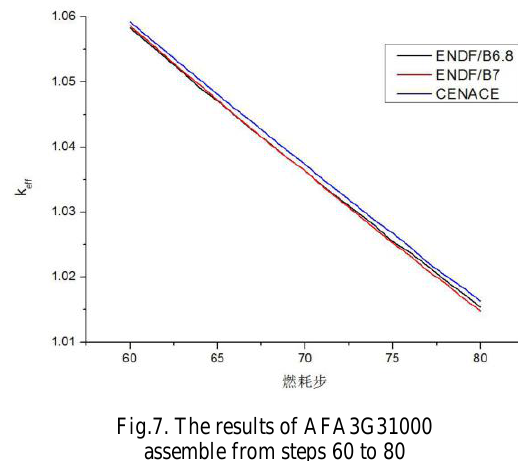
Fig. 4. Results of AFA3G31016 Assemble